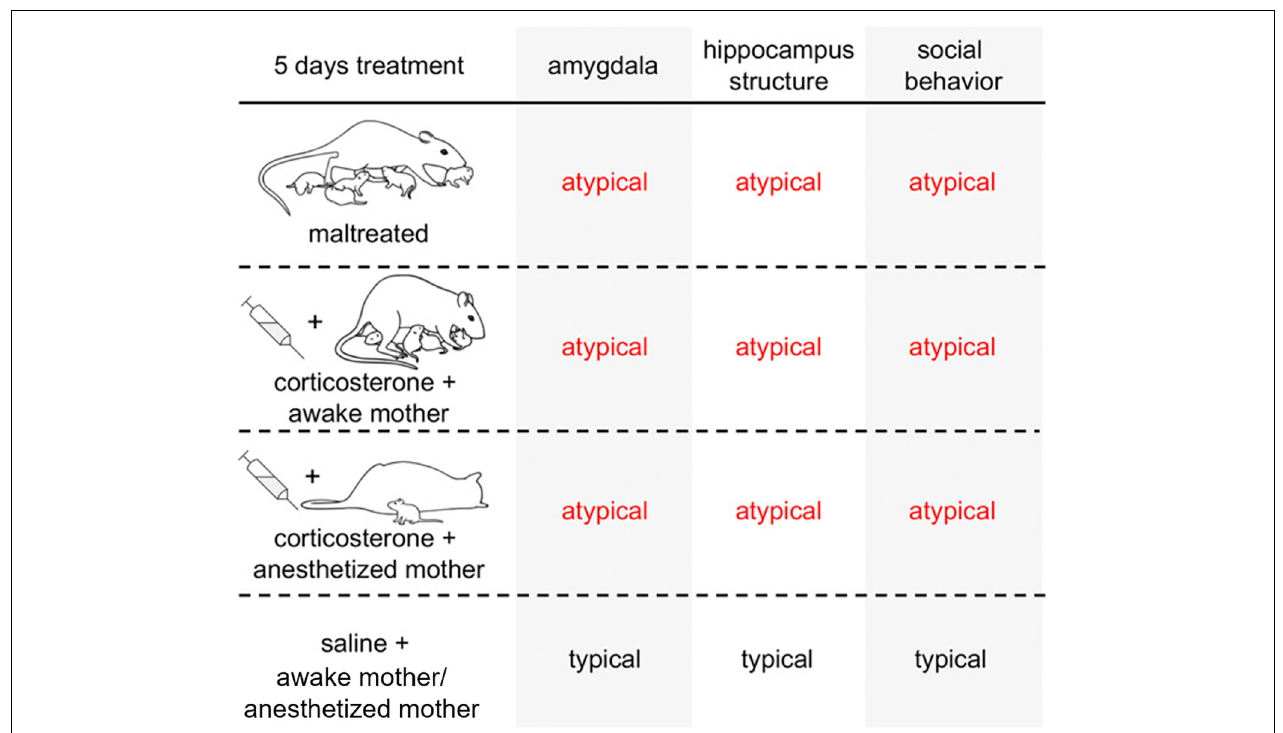
FIGURE 2 | Stress with the mother present impacts amygdala and social behavior, while stress alone impacts the hippocampus. Summary of behavioral and neural effects of maltreatment and corticosterone injection paired with a social context (awake or anesthetized mother). Maltreatment impacts both the hippocampus and amygdala. The effects of maltreatment on the hippocampus can be mimicked simply by repeatedly injecting pups with corticosterone, regardless of whether the adversity occurred in a social context. On the other hand, the effects of maltreatment on the amygdala required a social context that was independent of maternal behavior: stress hormone increased within the context of a maltreating mother, a nurturing mother, or an anesthetized mother all produced similar outcomes on the amygdala and social behavior.